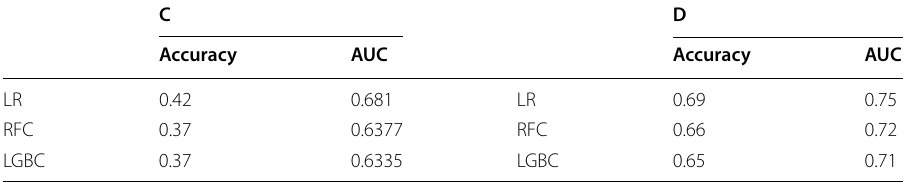
Table 9 Classification models results of accuracy and area under the curve for First Income variable